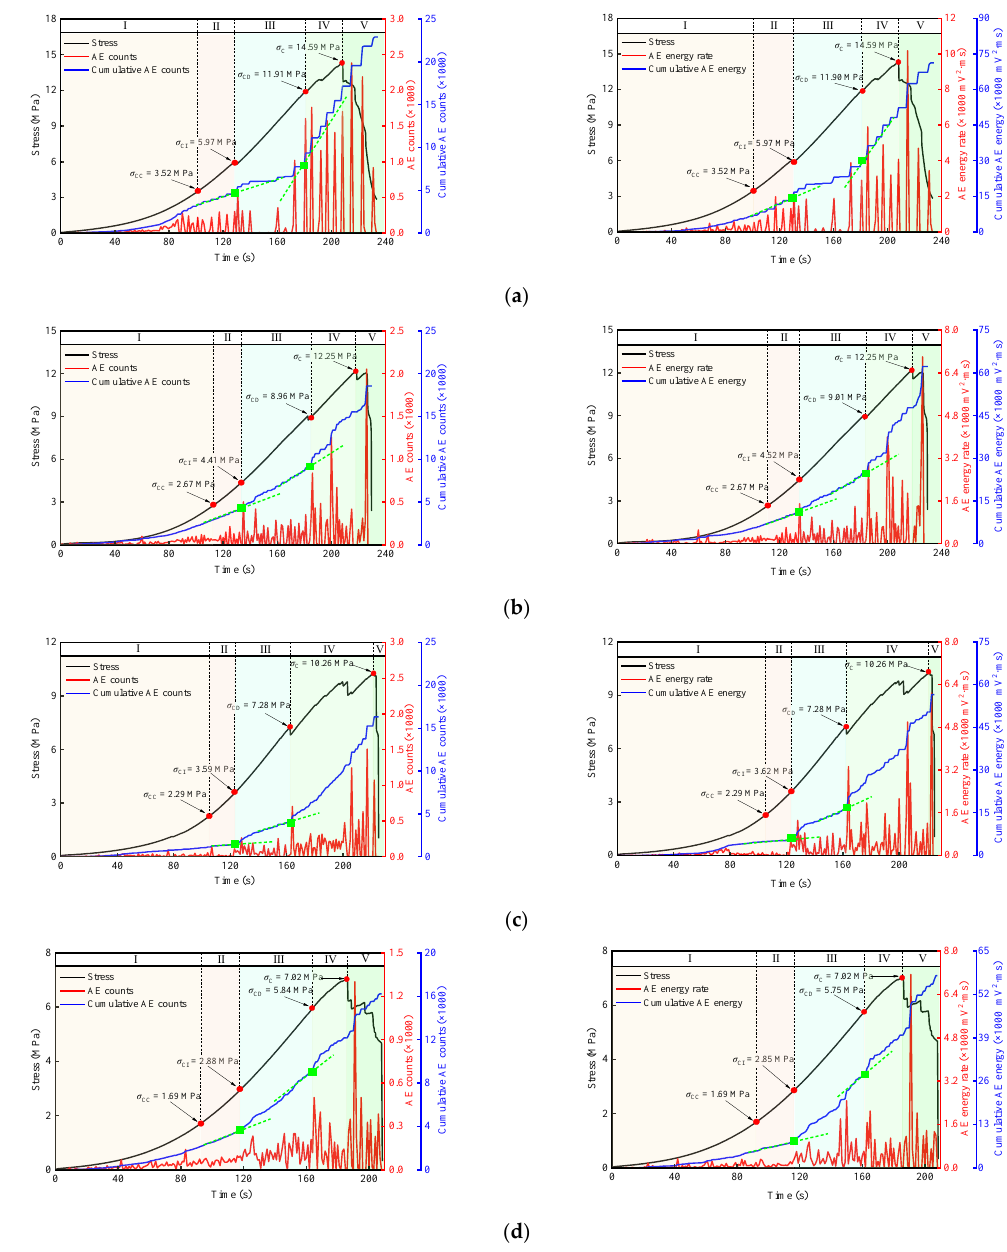
Figure 13. Curves of cumulative AE parameters (counts and energy) versus time at different inclination angles when the moisture content was 7.55%: ( a ) θ = 0°; ( b ) θ = 5°; ( c ) θ = 10°; ( d ) θ = 15°.